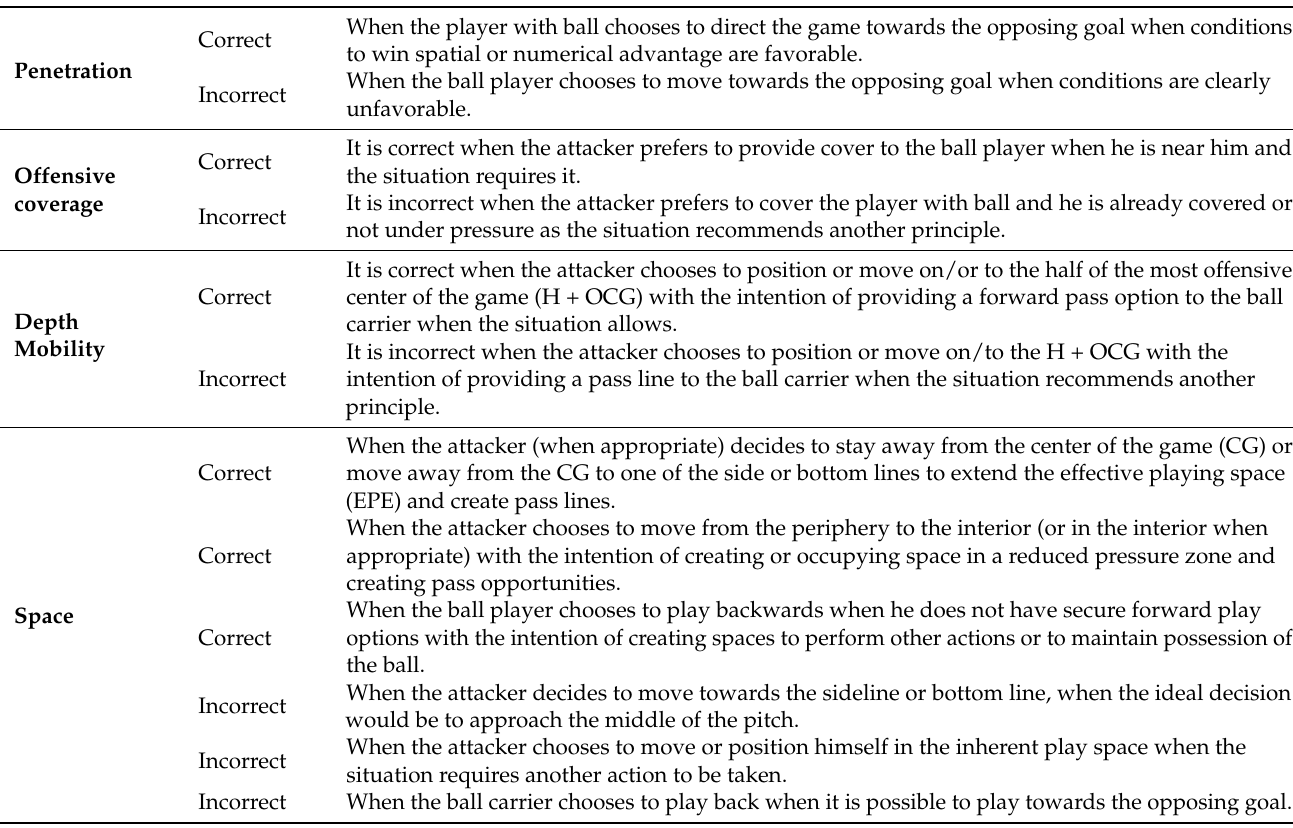
Table 2. Decision making classification regarding performance indicators as correct and incorrect in specific offensive game